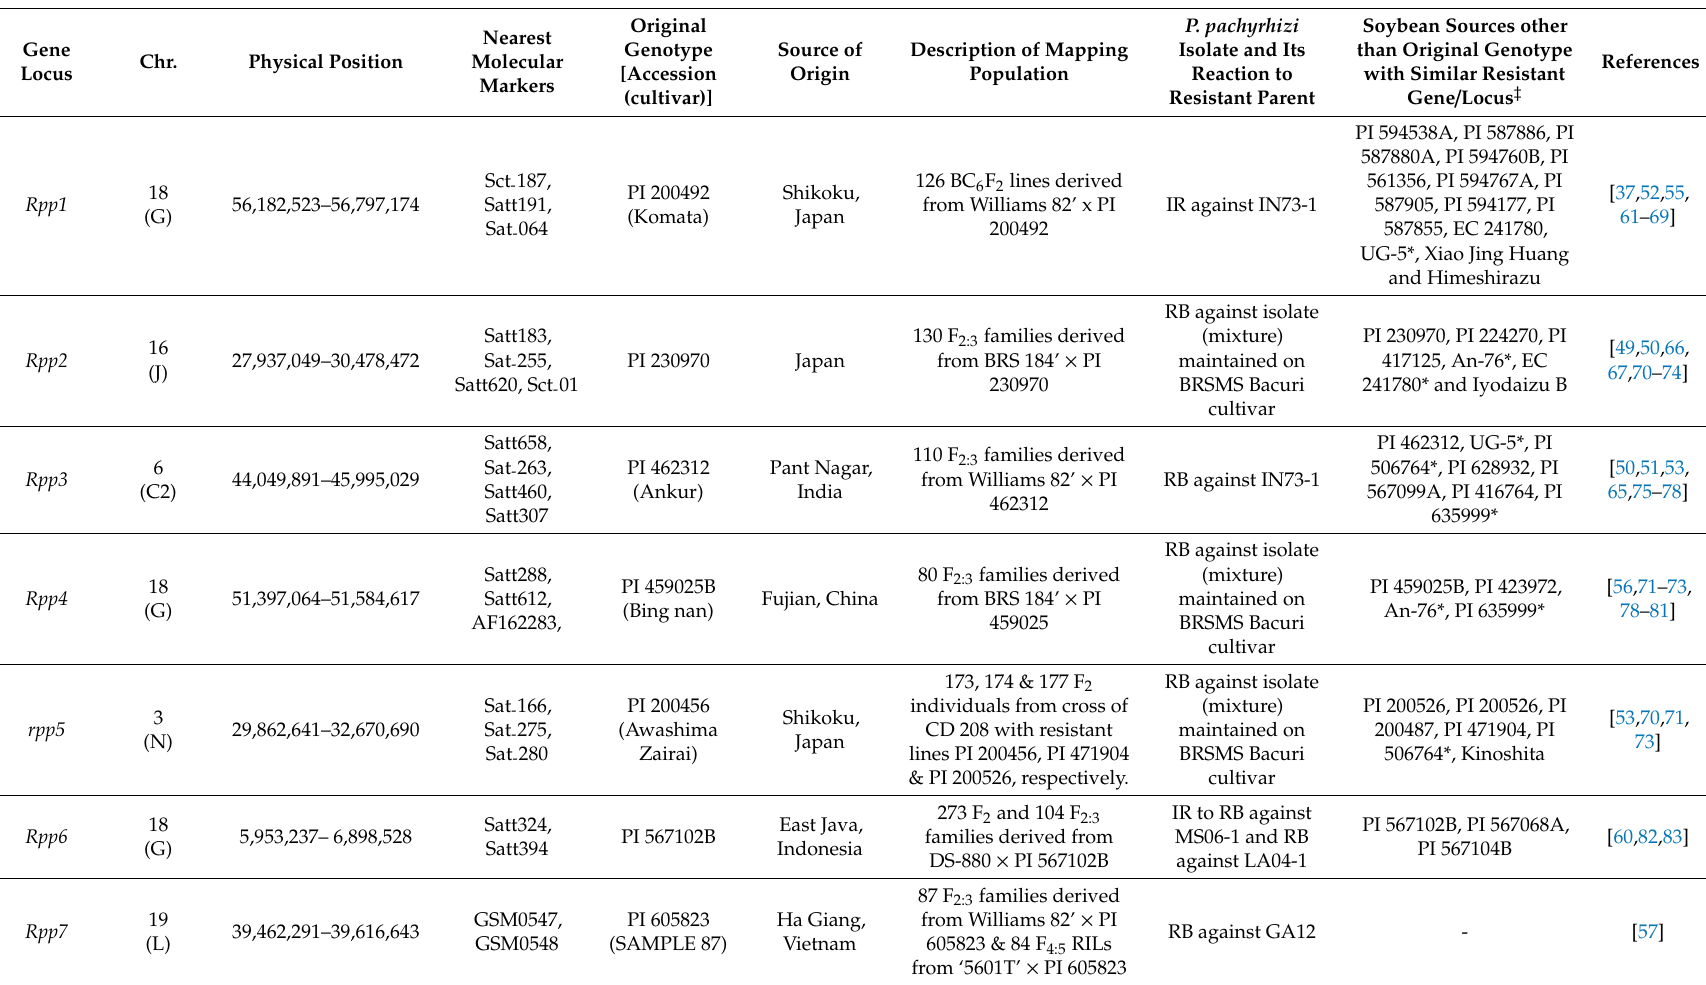
Table 2. Description of Rpp genes, genomic positions, nearest molecular markers and their original as well as other sources in soybean germplasm. Gene Locus